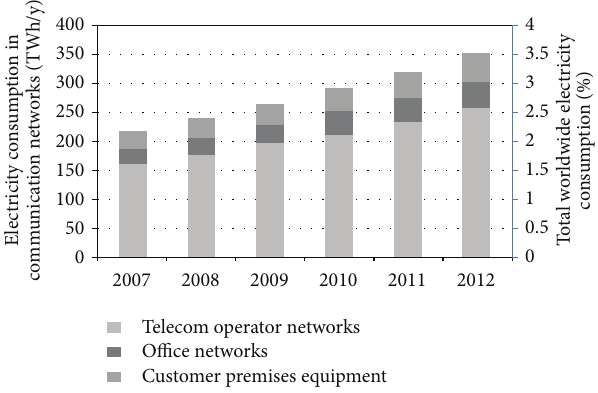
Figure 2: Worldwide electricity consumption by communication networks [6].